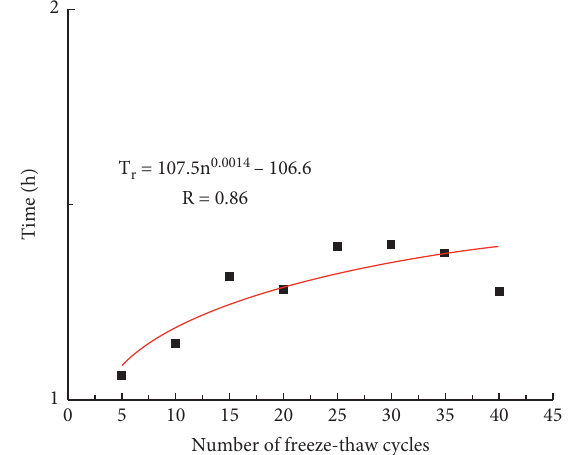
T f = 2.09n 0.29 – 0.14 R = 0.98